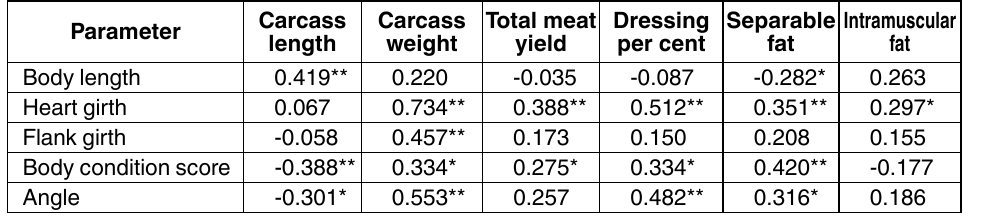
table 2. Coefficients of correlation between different live animal and carcass parameters of pigs from weight group